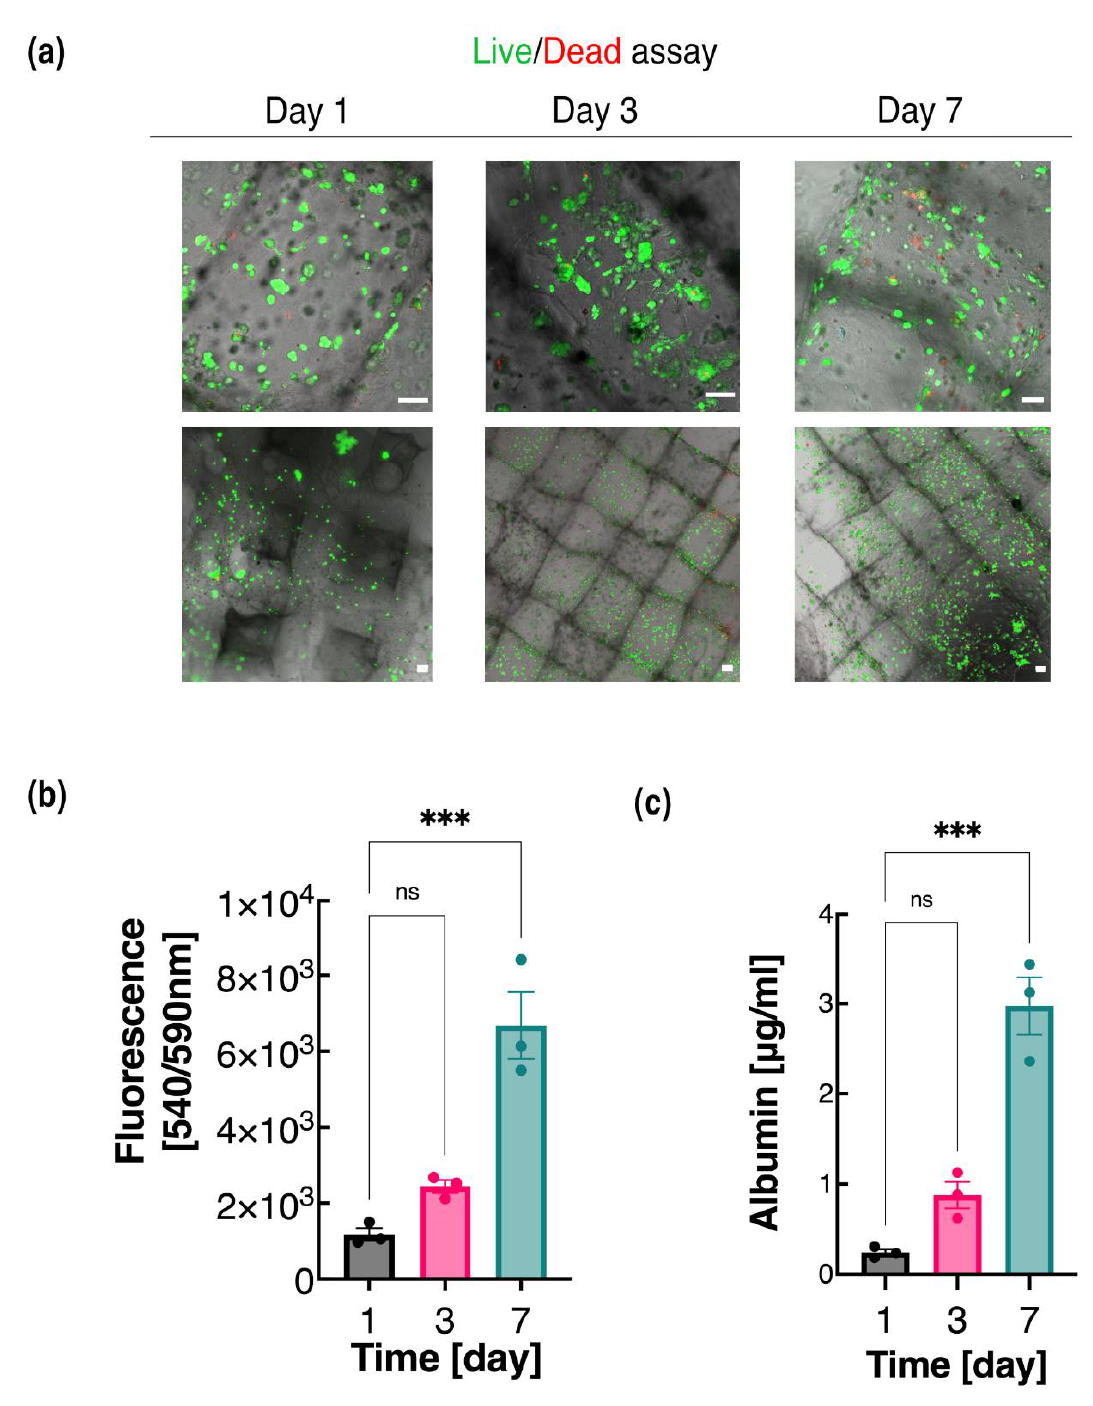
Figure 5. HepG2 cell proliferation embedded in dLM-G-PEG-T construct. ( a ) Live/dead images on day 1, day 3, and day 7 using 10× objective (top) and 2.5× objective (bottom) (scale bar 100 μm), ( b ) Alamar blue assay measurement of cell metabolic activity with fluorescence intensity at 540 nm excitation and 590 nm emission, and ( c ) albumin secretion measurements at various time points. All experiments were conducted in triplicate. Error bars show the standard error of the mean (*** p < 0.001).